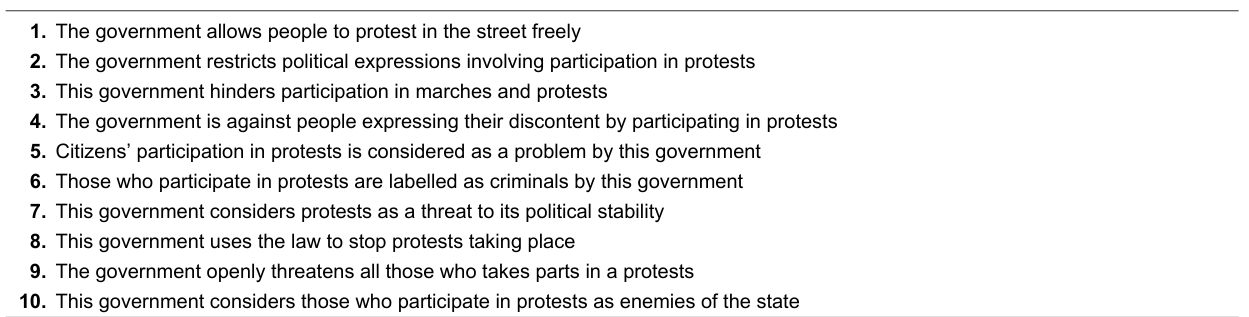
Note. M0 corresponds to the baseline model without any restricted parameter; M1 to the model testing weak invariance; M2 to the model testing strong invariance, M2P to the model testing partial strong invariance; M3P to the model testing partial strict invariance; M4P to the model testing the invariance of latent factor (variance); and M5P to the model testing the invariance of latent factor